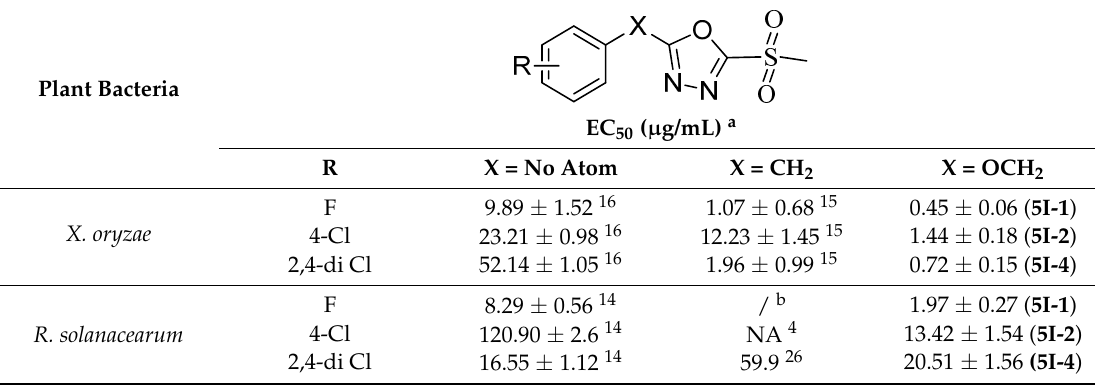
Table 4. The Contribution of 2-Substituents in 1,3,4-Oxadiazole Ring towards Antibacterial Activity.